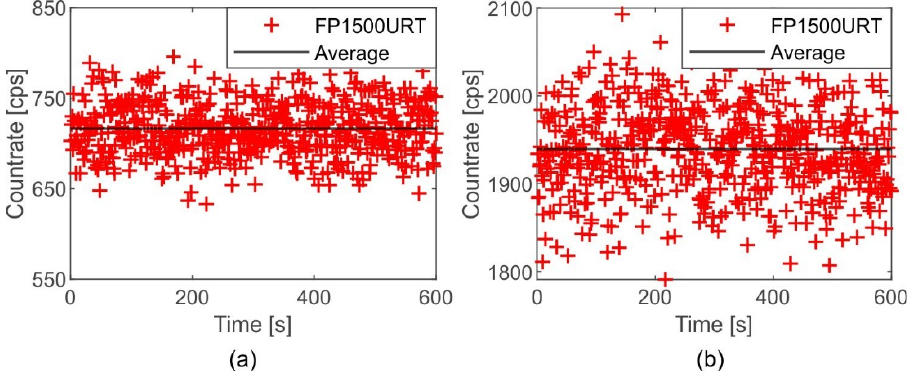
Figure 4. Sample raw data output signals from ( a ) the SPC and ( b ) the PMT detectors for 600 s. The graph also shows the average observed countrate.